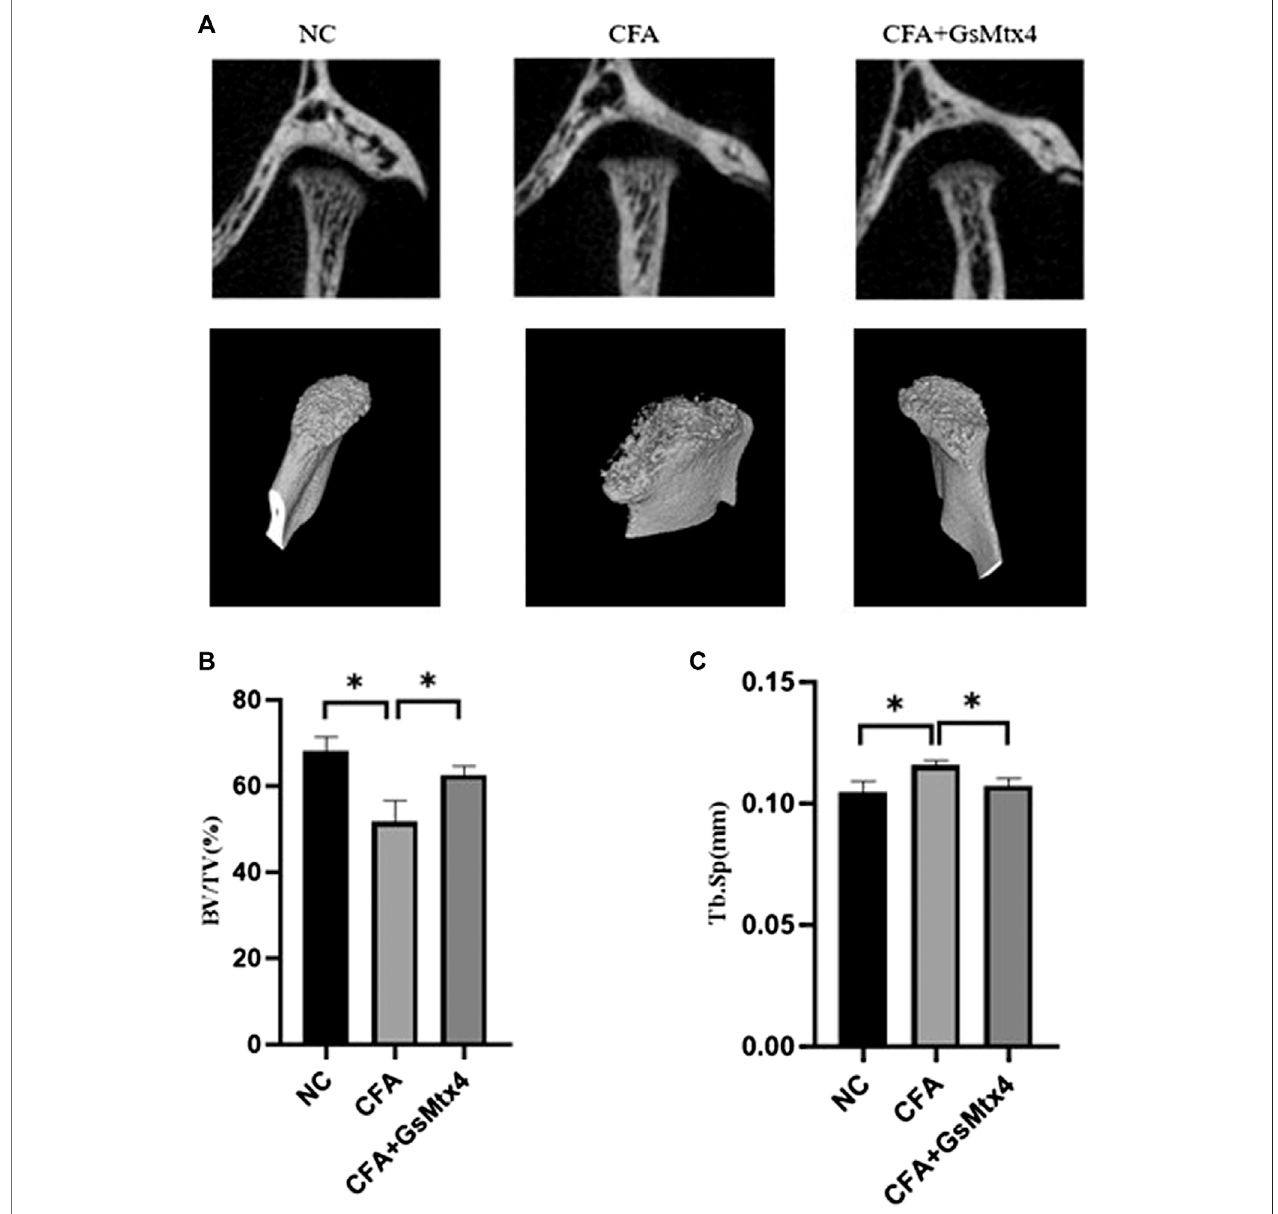
FIGURE1|(A) Coronalpositionand3DreconstructionimageshowthatmorecondylarbonewasabsorbedintheCFAgroupthanintheothertwogroups. (B) BV/ TV:ThebonevolumefractionintheCFAgroupwaslowerthanthatintheothertwogroups,andthedifferencewasstatisticallysigni fi cant. (C) Tb.sp:Thetrabecularbone separation value in the CFA group was higher than that in the other two groups. * p <